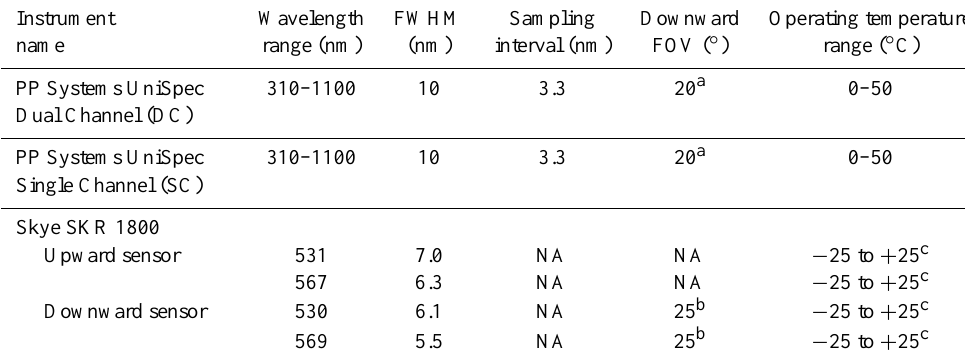
Table 1. Principal characteristics of the optical instruments used. Instrument Wavelength FWHM Sampling Downward Operating temperature name range (nm) (nm) interval (nm) FOV ( ◦ ) range ( ◦ C)